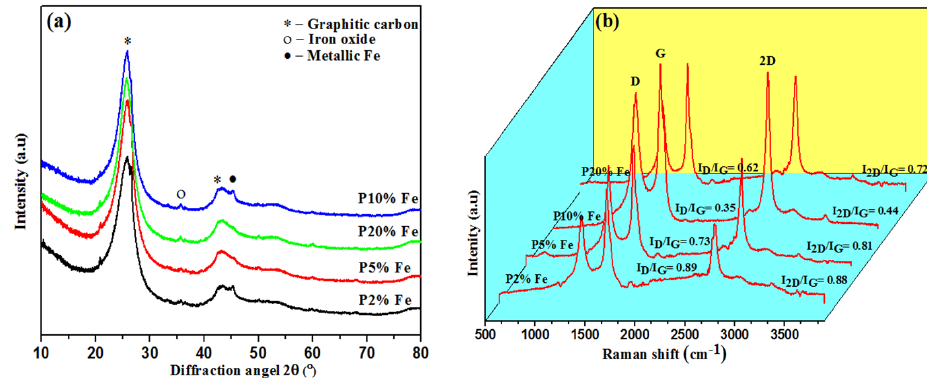
Figure 1. ( a ) XRD and ( b ) Raman spectra of the Fe-loaded samples. Table 1. Structural properties at the different percentages of Fe catalyst. Catalyst Loading (% of P2 Fe)/Parameters Interlayer spacing (d 002 ) (nm)